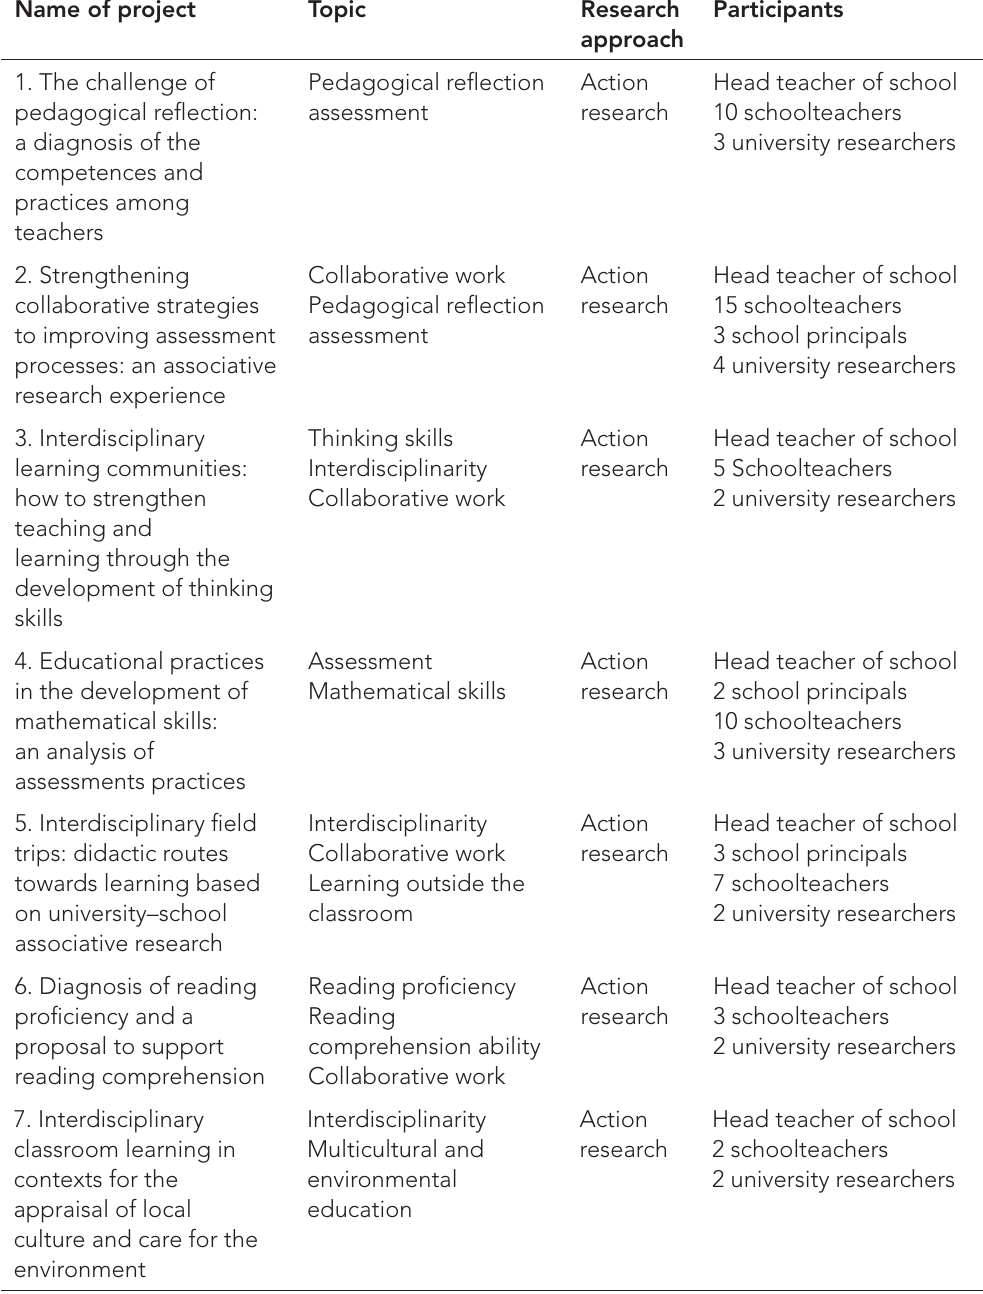
Table 1: Project